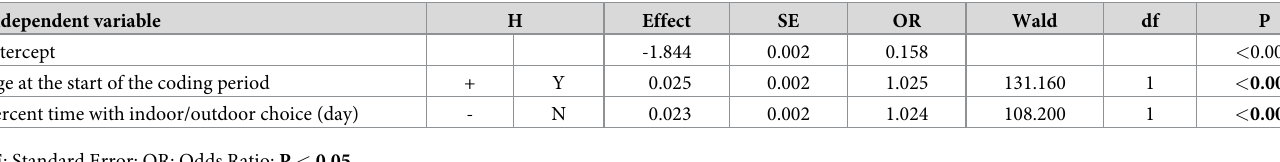
Table 11. Multivariate assessment of the occurrence of skin lesions by binomial regression, counting each animal as having experienced (n = 77) or not (n = 135) this type of pathology. Hypotheses (H): positive (+) or negative (-) relationship of each variable with the occurrence of clinical events per animal as a measure of elephant welfare, and whether observed relationships were in the predicted direction (Y yes / N no).